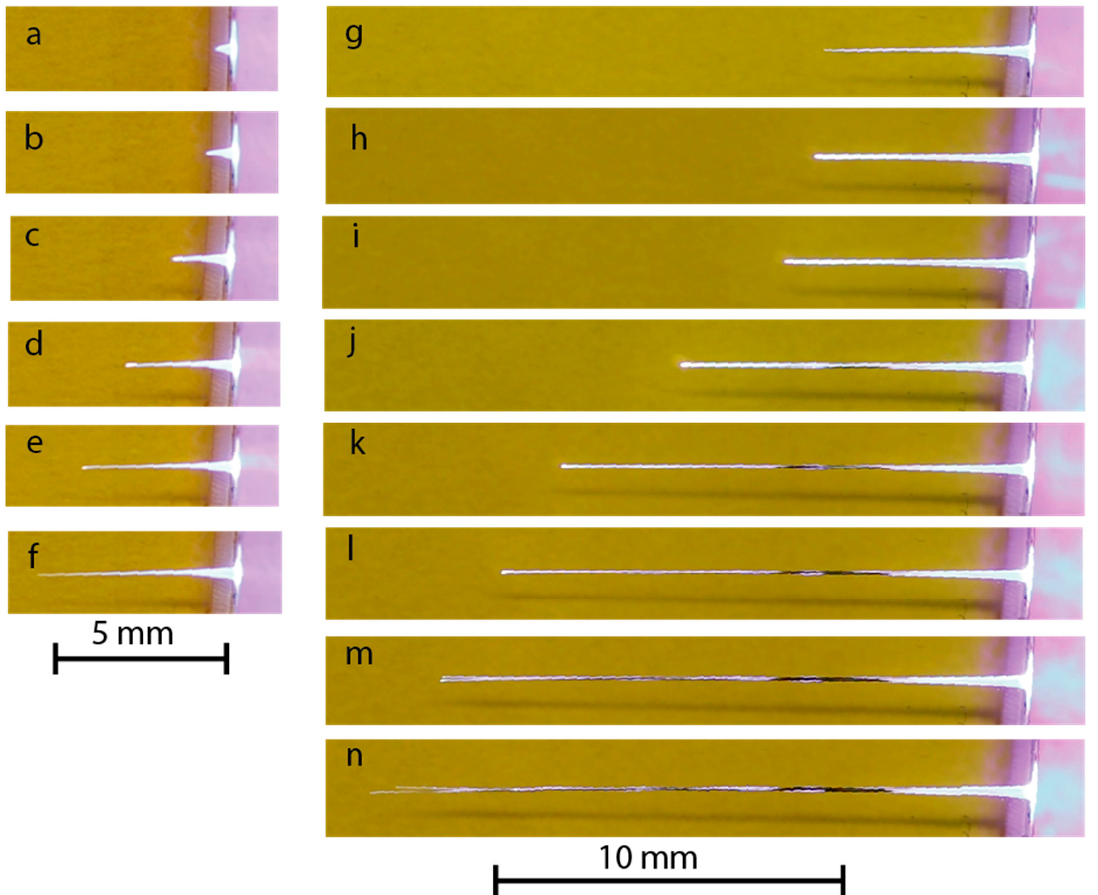
Figure 4. Video frame sequence of the growing channel in PMMA for the pulse energy ( a – g ) E L ≈ 2.8 and ( h – n ) 7 mJ. The laser beam falls on the sample from the right.